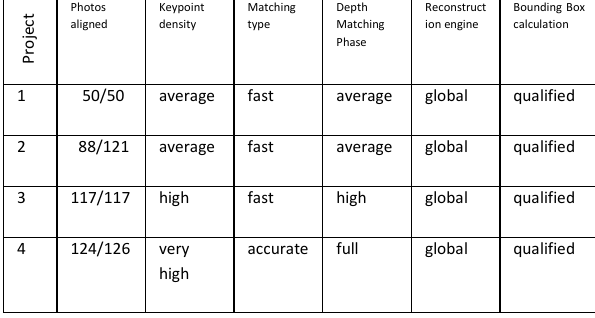
Table 1. varied parameters for the raw cloud